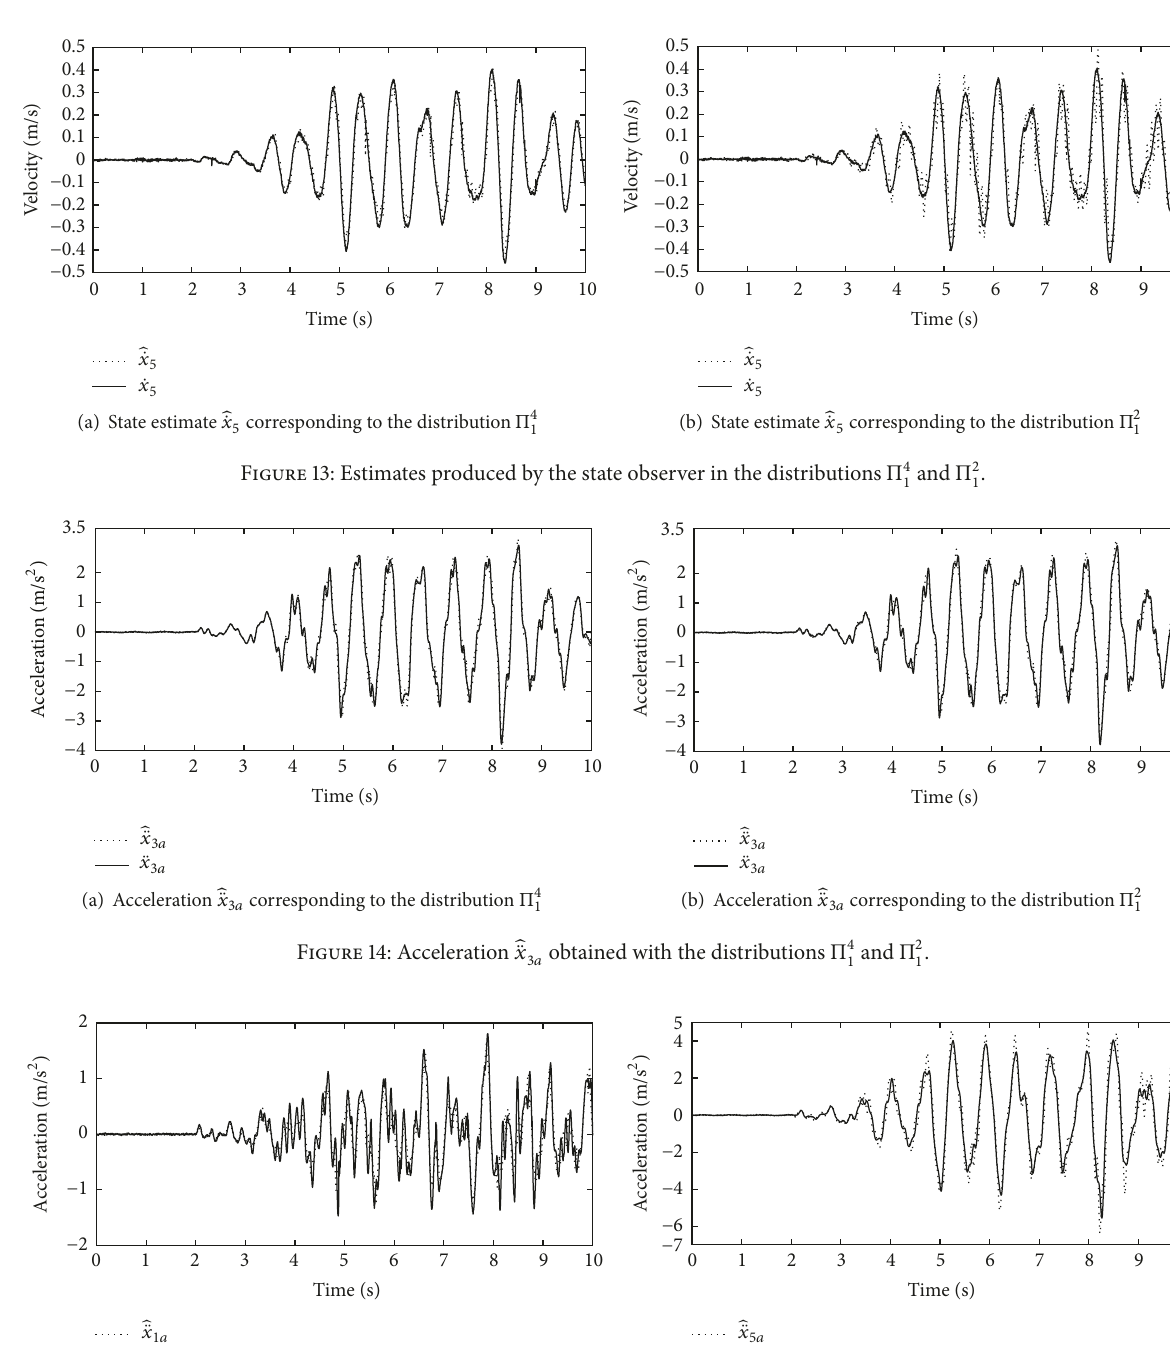
(b) Acceleration ̂̈𝑥 5𝑎 obtained with the distribution Π 2 1 ̂̈𝑥 5𝑎 corresponding to the distributions